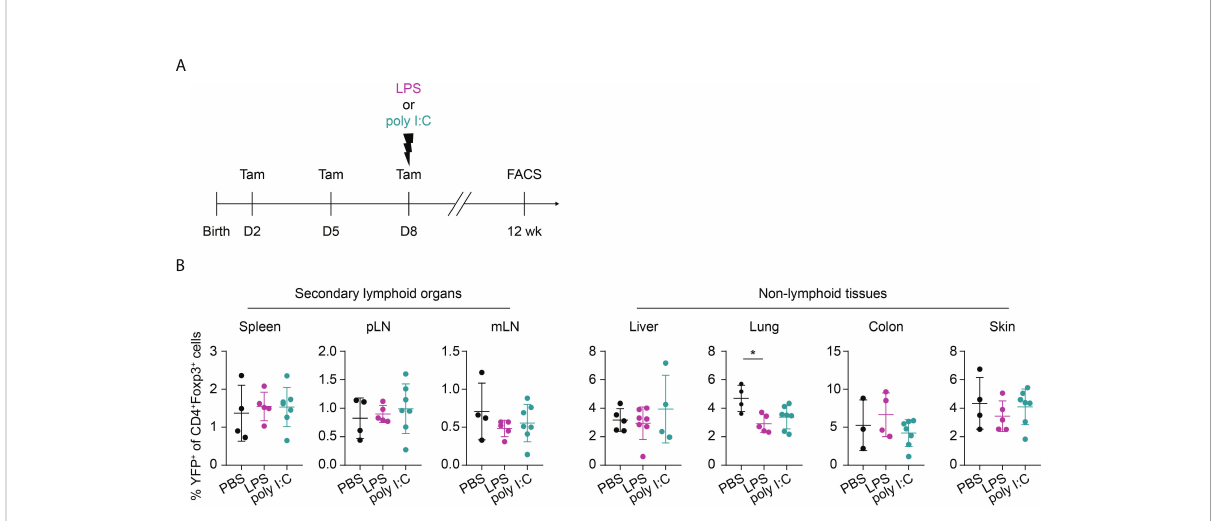
FIGURE 5 No long-term impact on neonatally generated Tregs upon later challenge. (A) Foxp3 eGFPCreERT2 xROSA26 STOP-eYFP mice received repetitive intragastric tamoxifen injections at days 2, 5 and 8 after birth, directly followed by an intraperitoneal injection of LPS, poly I:C or PBS on day 8. Twelve weeks later, mice were sacri fi ced for immunophenotyping. (B) Scatter dot plots summarize frequencies of YFP + cells among Foxp3 + Tregs in secondary lymphoid organs (left) and non-lymphoid tissues (right). Data in scatter dot plots are depicted as mean ± SD, each dot represents a single mouse, and data were pooled from 2 independent experiments (n = 4-7). * p <